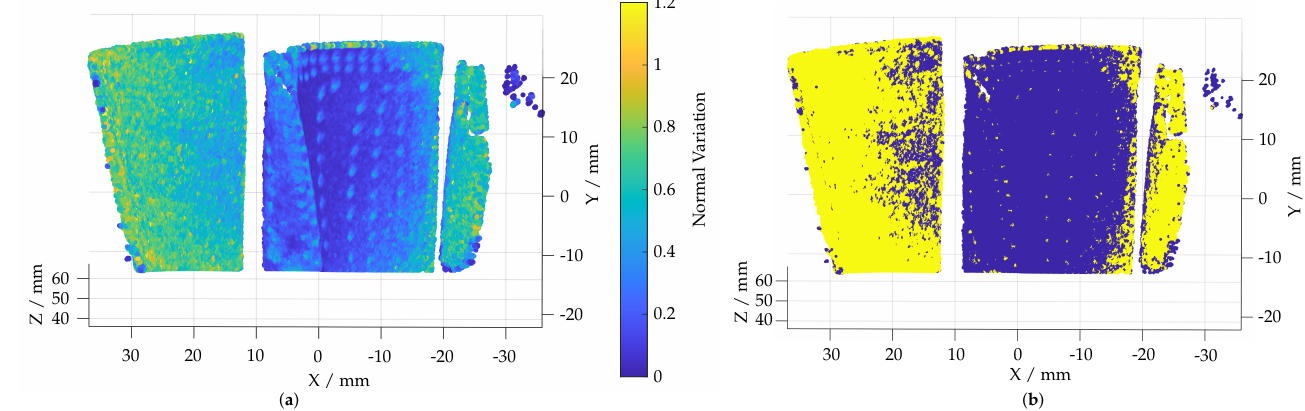
Figure 6. Visualization of the normal variation approach used to identify film-cooling holes. ( a ) Normal variation ζ plotted on the reconstructed point cloud. ( b ) Threshold applied to the calcu- lated normal variation. Areas with strong changes in normal direction colored